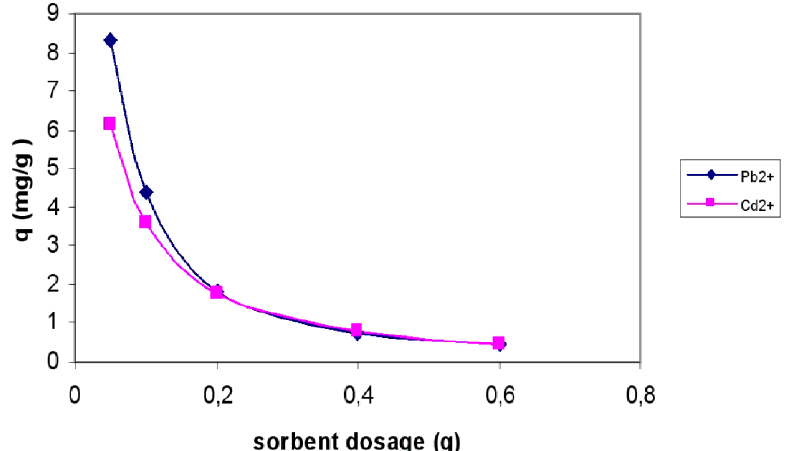
Fig. 5 In®uence of sorbent dosage (sample R) on the adsorption capacity of Cd and Pb at a initial Pb and Cd concentration of 10 mg/l.